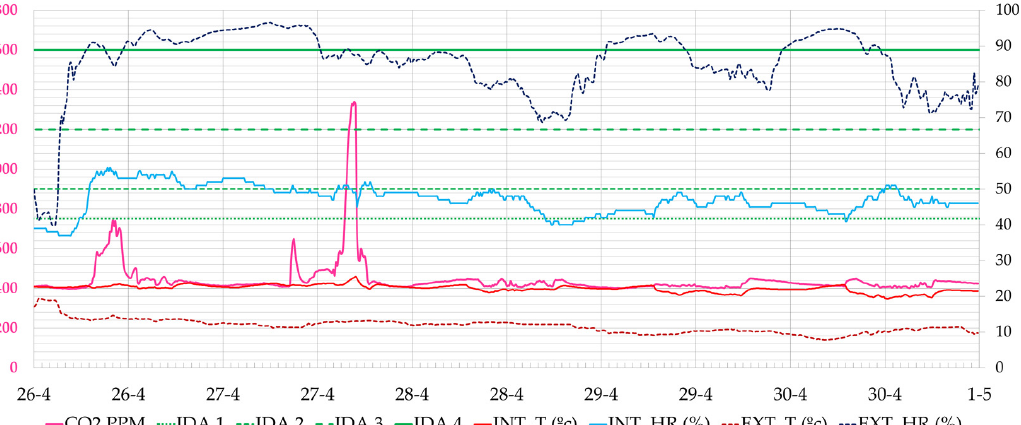
Figure 19. Evolution of CO 2 concentration, interior and exterior temperature and relative humidity in classroom A 1.1 during the week 26 April 2021 to 2 May 2021 (Phase II). Source: